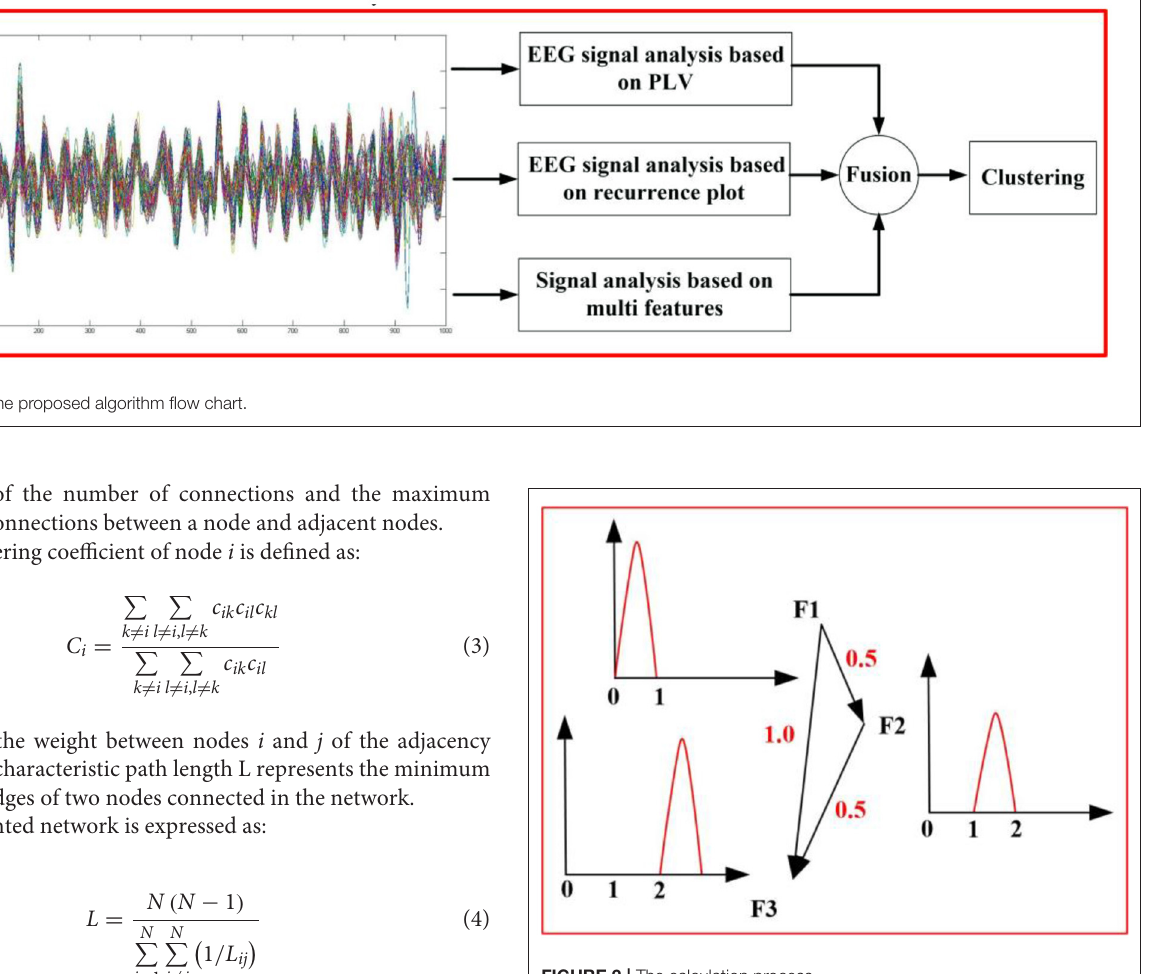
FIGURE 2 | The calculation